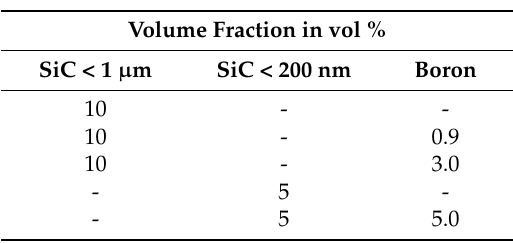
Table 1. Composition of the investigated AMCs (aluminum matrix